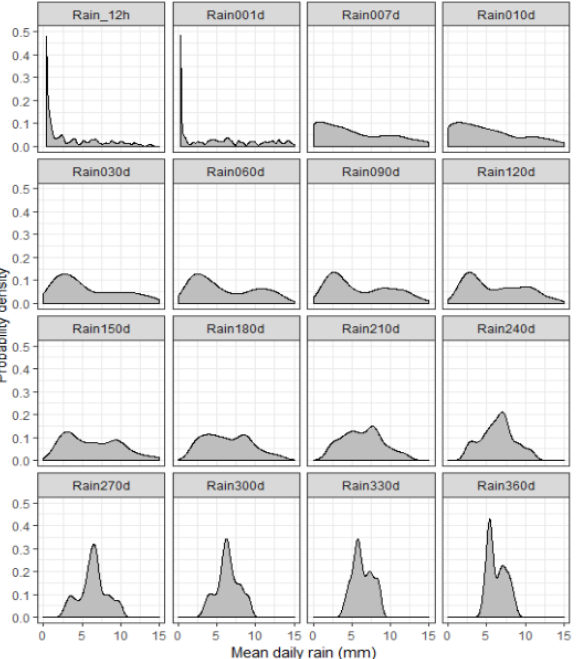
Figure 3. Probability density of accumulated mean daily rain indexes. Rain[i]d stands for “Accumulated [i] days rain/[i]”.